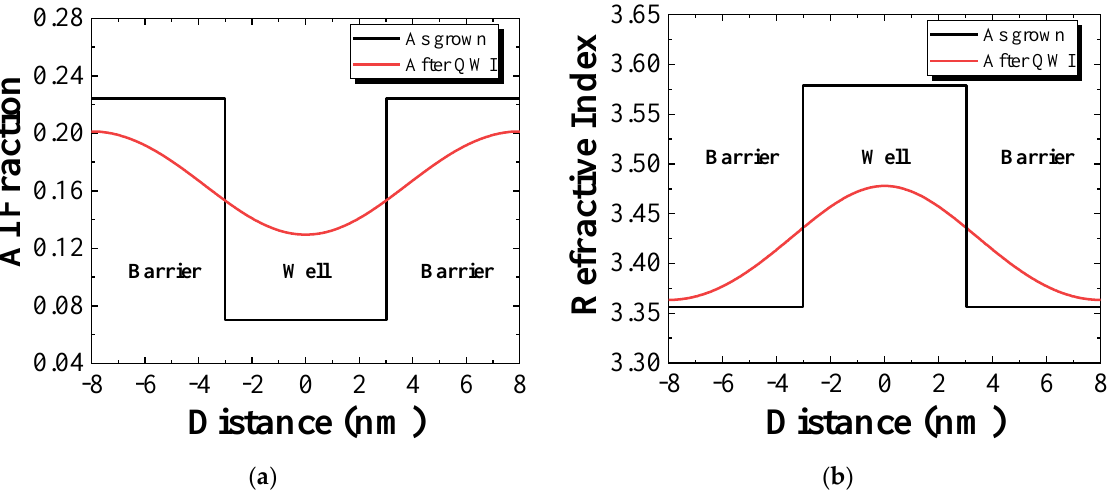
Figure 3. ( a ) Al composition and ( b ) reflective index distribution at 1.5 µm wavelength through one period of the MQW after intermixing by 200 nm.